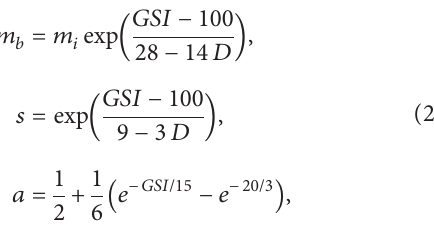
Figure 4: Typical constitutive model of coal rock mass.